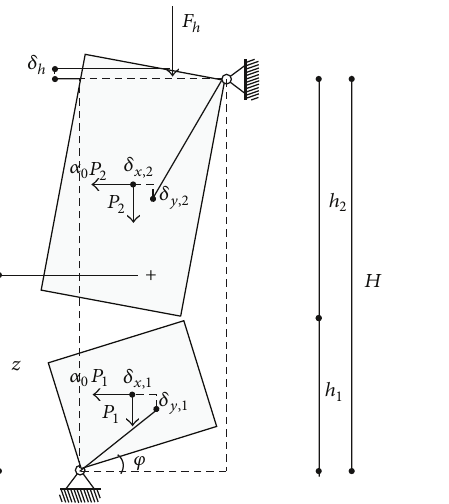
Figure 10: Limit analysis: representation of a generic mechanism due to the application of 𝐹 ℎ force and self-weights.